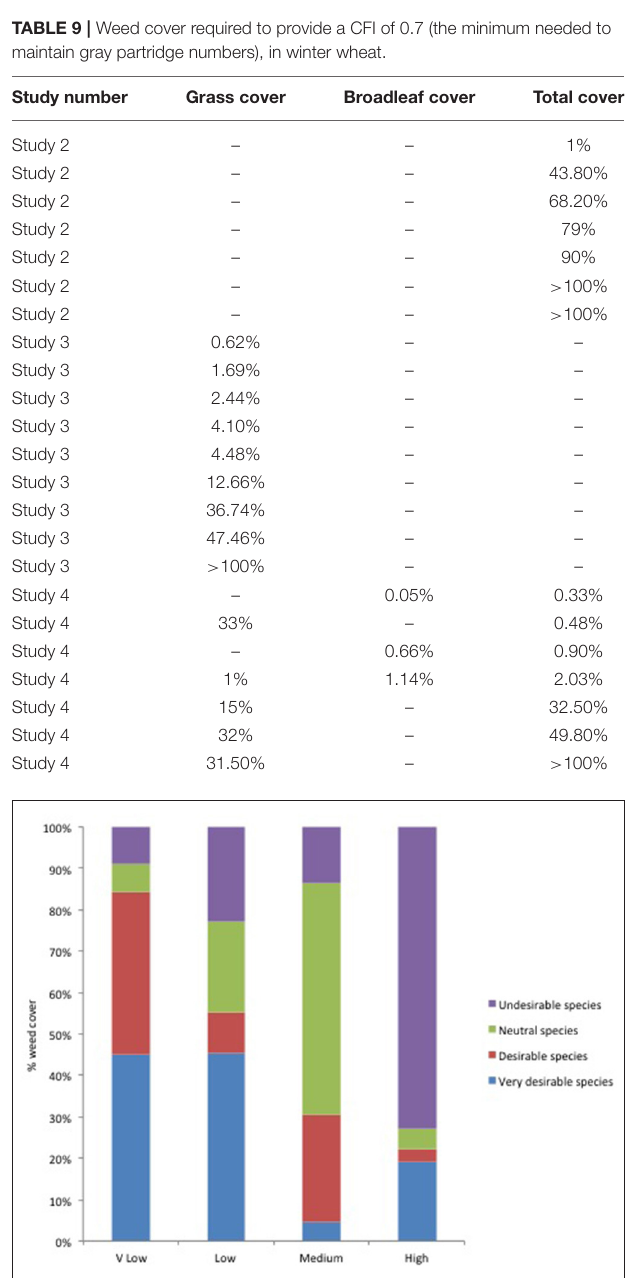
FIGURE 1 | The weed cover necessary to reach the critical value of CFI 0.7 in three of the seven categories was categorized as: Very (V) low = < 1%; Low = 1–10%; Medium = 20–60%; High = > 60%. The proportion of weeds of four levels of desirability [Very desirable, Desirable, Neutral and Undesirable, according to Jones and Smith (2007) see Table S1 ], was calculated. These categories are based on known agronomic and biodiversity traits and were deigned as an accessible guide for farmers (Jones and Smith, 2007). The percentage cover of the more desirable taxa, known to be associated with high insect abundance, was higher for where weed levels were lower.